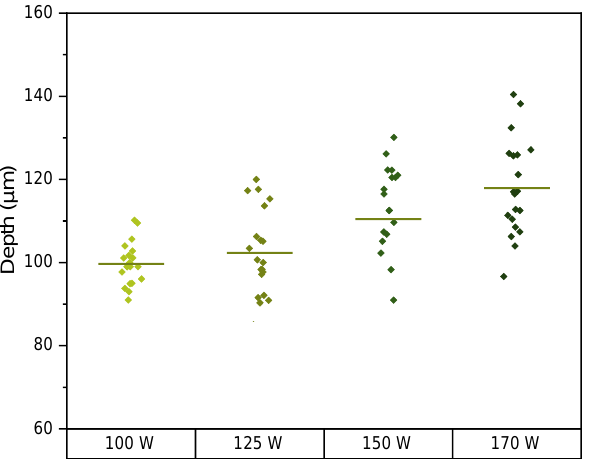
Figure 5. Results of melt pool morphology investigation as a function of laser power value used.